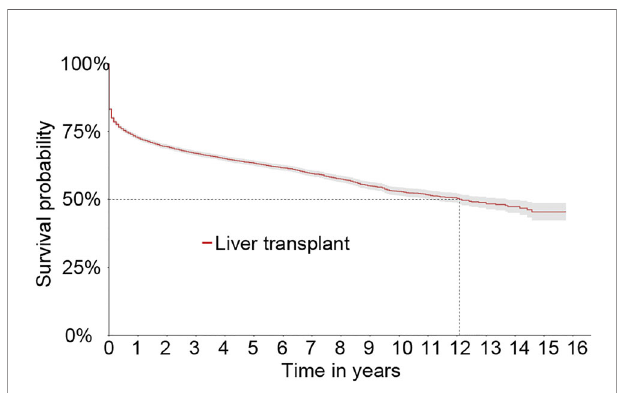
FIGURE 2 | Kaplan-Meier survival curve of liver grafts from 2000 to 2015 in the Full cohort.